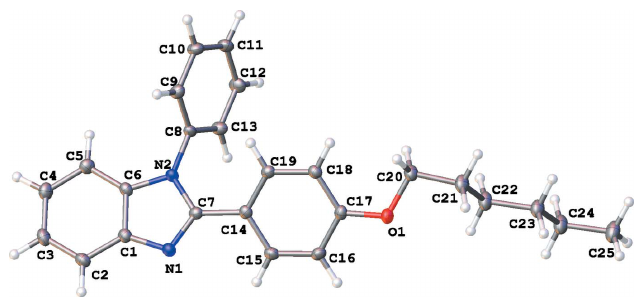
Figure 2 The molecular structure of 2-(4-hexyloxyphenyl)-1 - phenyl-1 H- benzimid- azole ( 2 ), with displacement ellipsoids drawn at the 50% probability level.